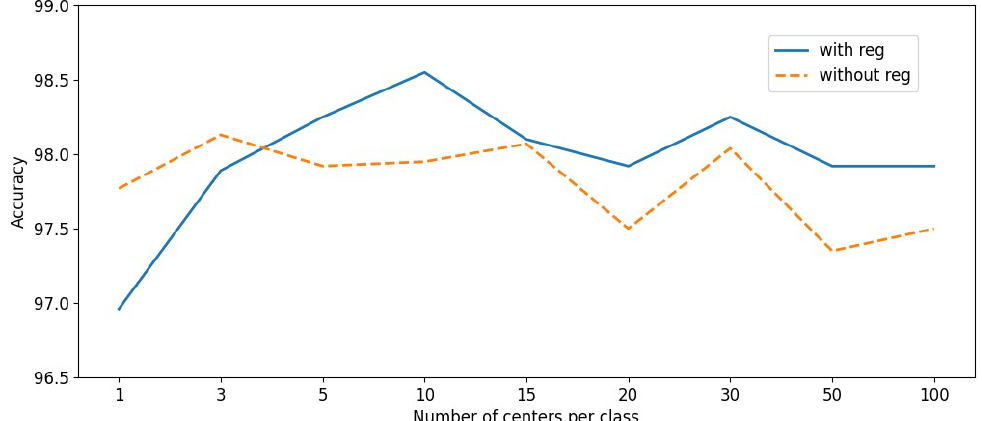
Figure 5. Study of the number of centers and the L 2,1 regularization. When the number of centers for each class increases to 5, the L 2,1 regularization starts to work and the accuracy decreases slightly while continuing to increase the centers to more than 10 due to the low efficiency of the redundant centers. Best viewed in color.